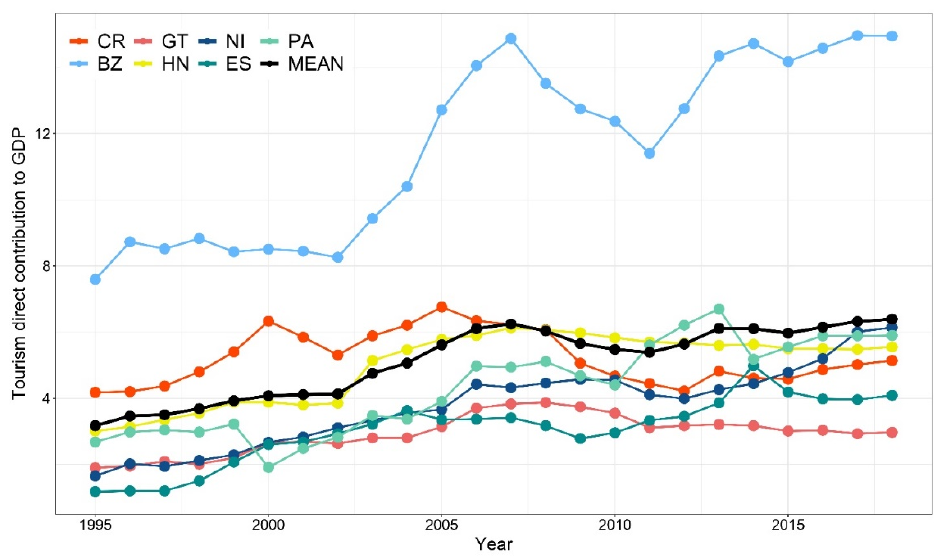
Figure 9. Tourism direct percentage contribution to every national GDP from 1995 to 2018.